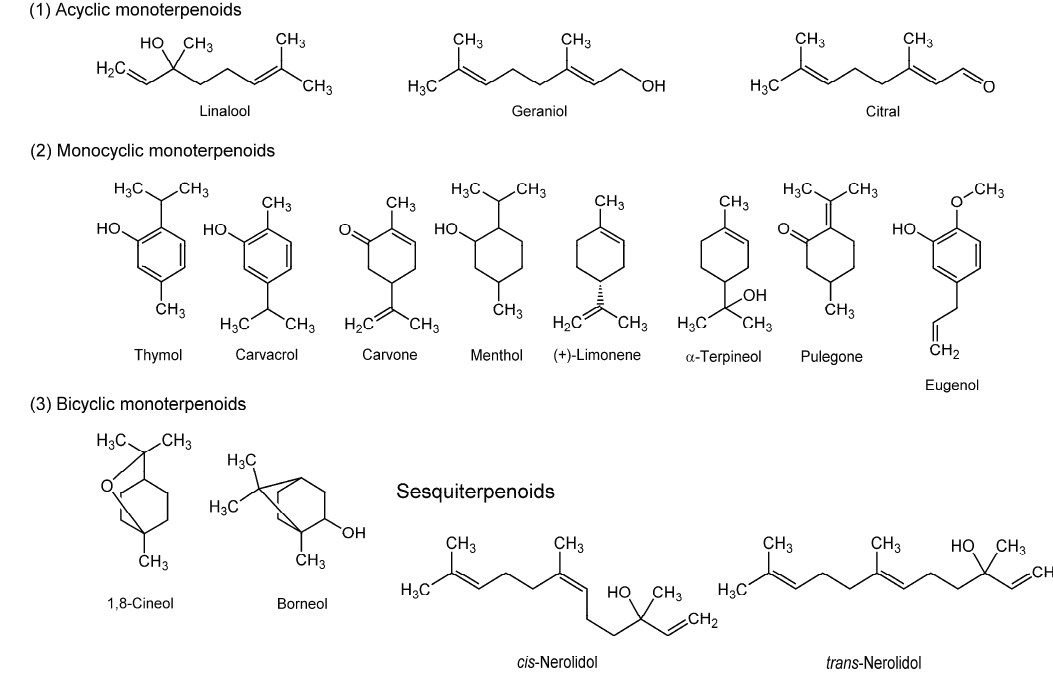
Figure 2. Structures of membrane-interactive